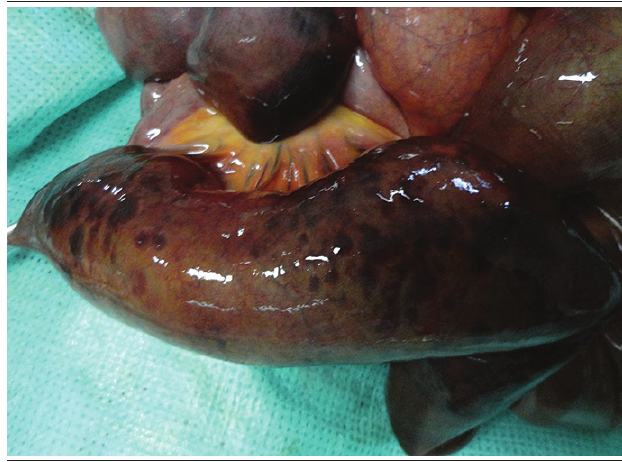
figurE 6 − Jejunal loops with friable points